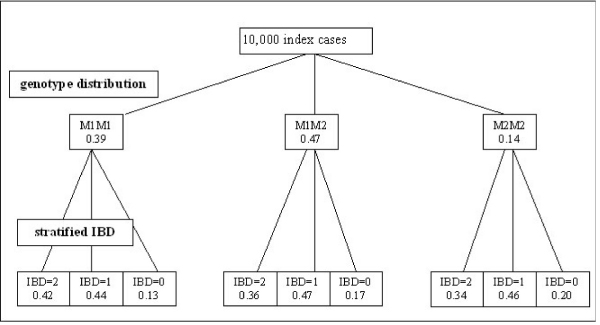
Distribution of the marker C03R0281 for the 10,000 index cases of the Aipotu population. The first level shows the genotype distribution of the 10,000 index cases for the marker M. The second level shows, for each marker genotype, the index cases classified according to their IBD sharing with one affected sib (stratified IBD distribution).